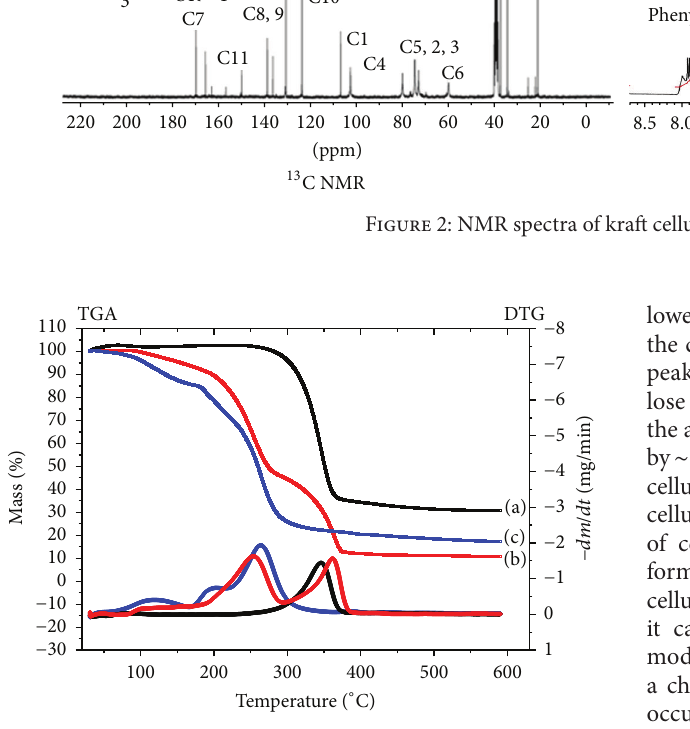
Figure 3: Thermogravimetric analysis TGA-DTG for kraft cellulose (a), p -nitrobenzoyl chloride (b), and cellulose p -nitrobenzoate (c).